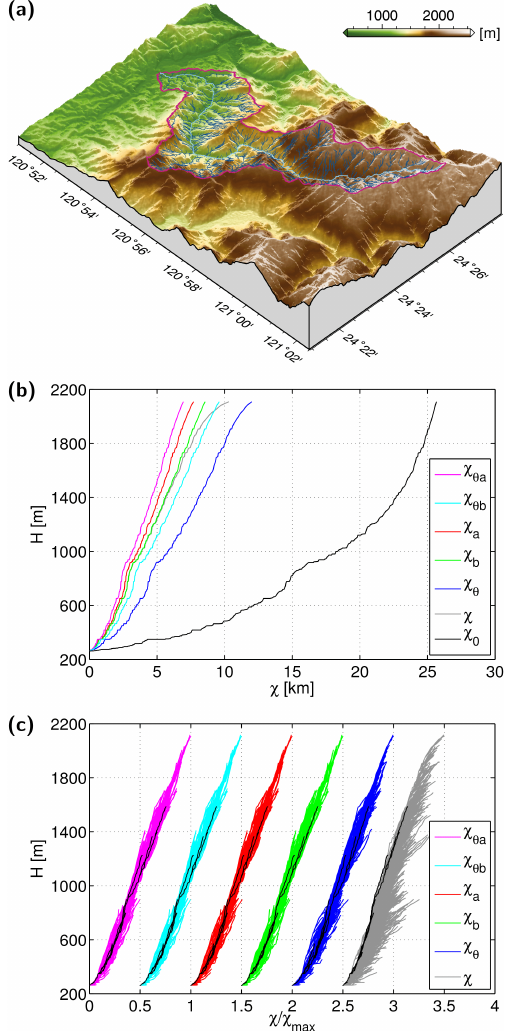
Figure 4. The mountainous catchment in Taiwan with the lowest χ disorder. (a) Topography and drainage pattern for A ≥ 0 . 01 km 2 . The largest river is drawn in light blue. (b) H vs. χ plots of the main river. χ 0 refers to θ = 0, so that χ 0 = x , and the plot describes the original river profile. (c) H vs. χ plots for the entire drainage net- work. The plots are shifted horizontally in order to avoid overlap- ping curves. The black lines show the part of the drainage network with A ≥ 1 km 2 .